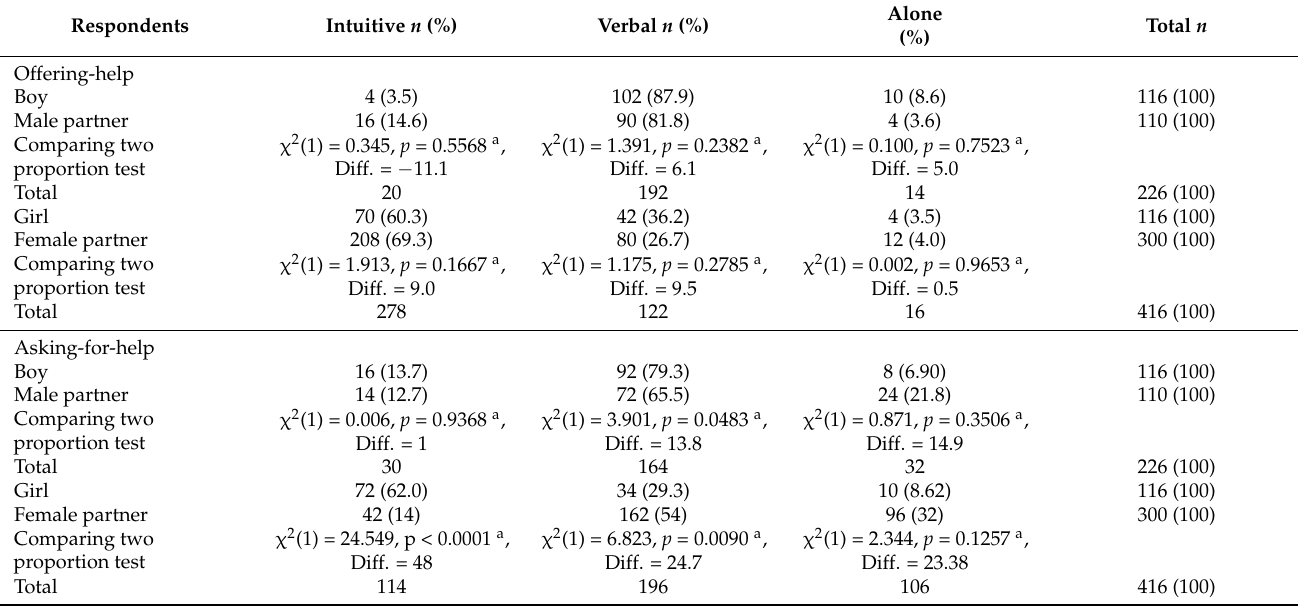
Table 5. Comparisons of the same-sex respondents by intuitive and verbal means in the condition of offering and asking for